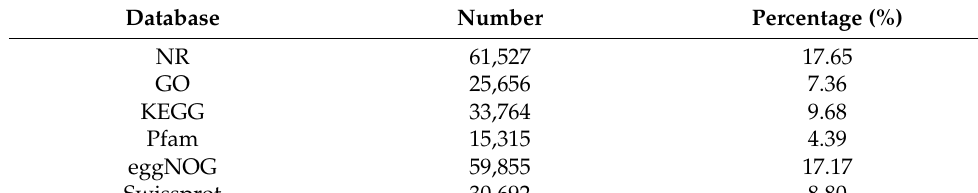
Table 5. Annotation statistics of unigenes in different databases.